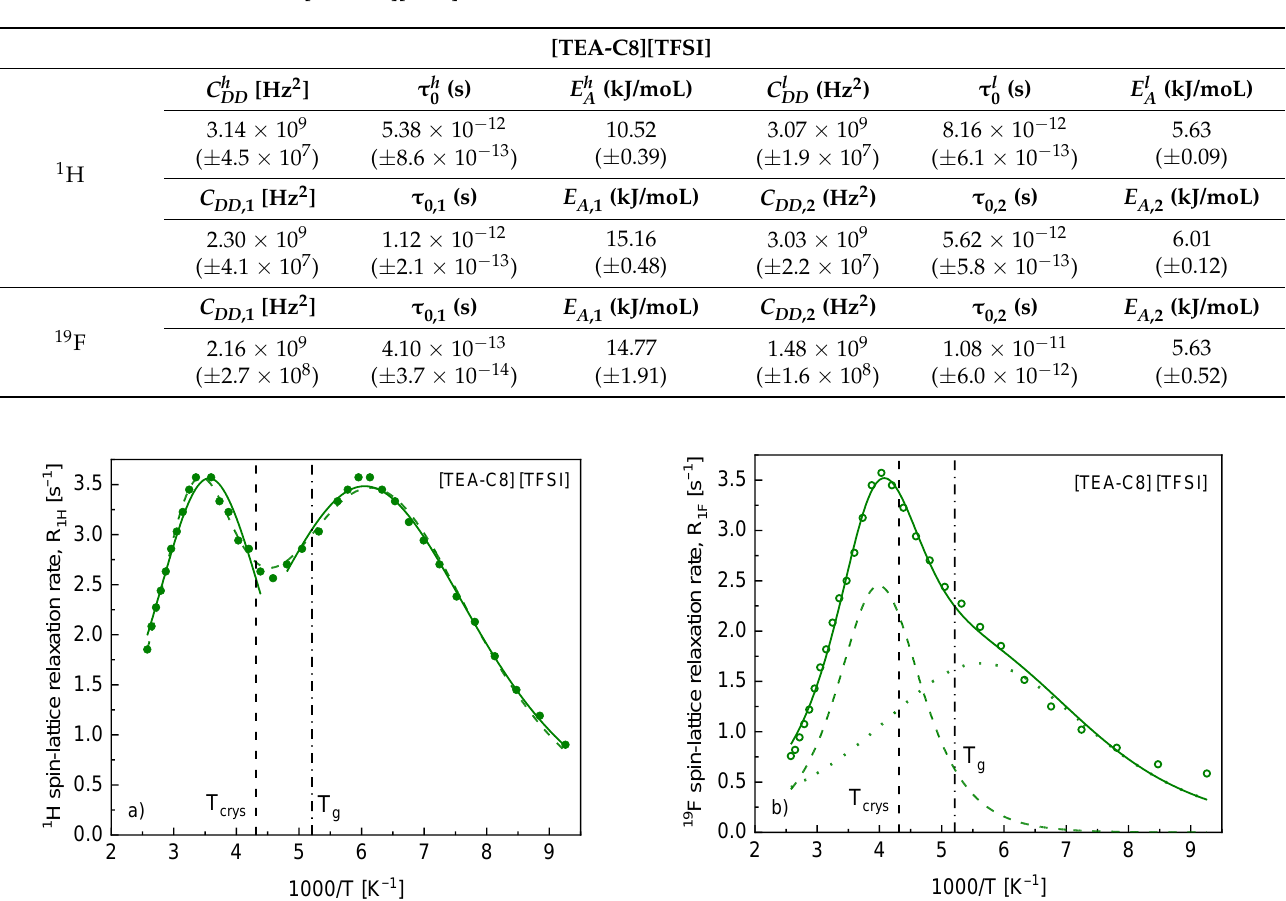
Table 2. Parameters obtained from the analysis of the 1 H and 19 F spin-lattice relaxation data for [TEA-C8][TFSI].